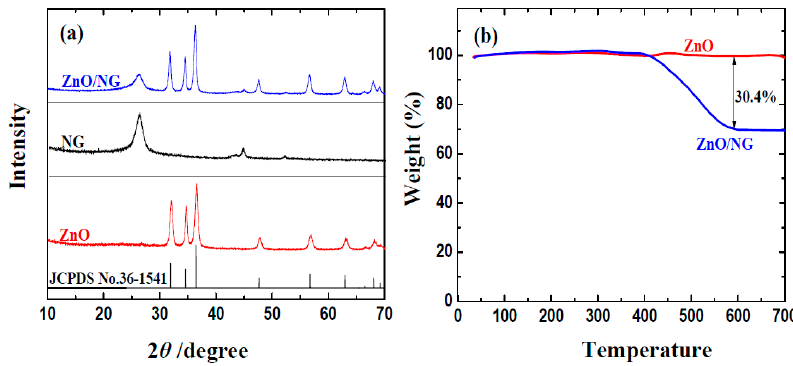
Figure 1. ( a ) XRD patterns, ( b ) thermogravimetric curves of ZnO and ZnO/NG composite.